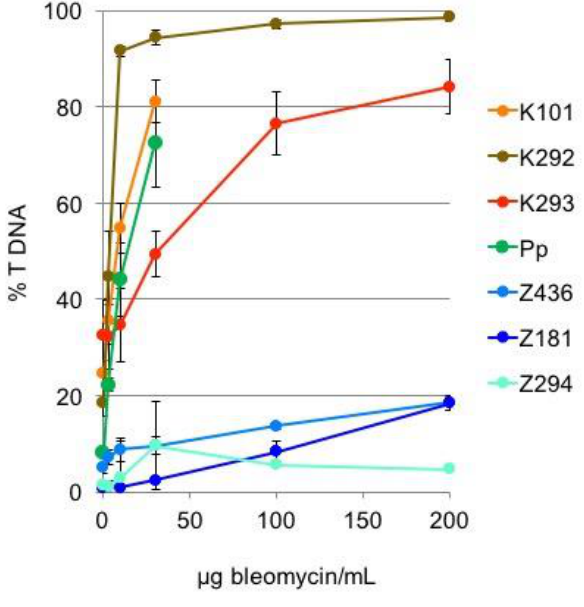
Figure 5. Bleomycin dose-response of Klebsormidium and Zygnema species. The cultures of K. flaccidum K101 (heavy orange), K. elegans K292 (brown), K. flaccidum K293 (red), Zygnema sp. Z436 (mid blue), Z . circumcarinatum Z181 (dark blue), Zygnema sp. Z294 (cyan), and Physcomitrella (Pp, green) were treated with an extended concentration range of bleomycin (0–200 µ g/mL) for 1 h and analyzed for induction of DSBs.